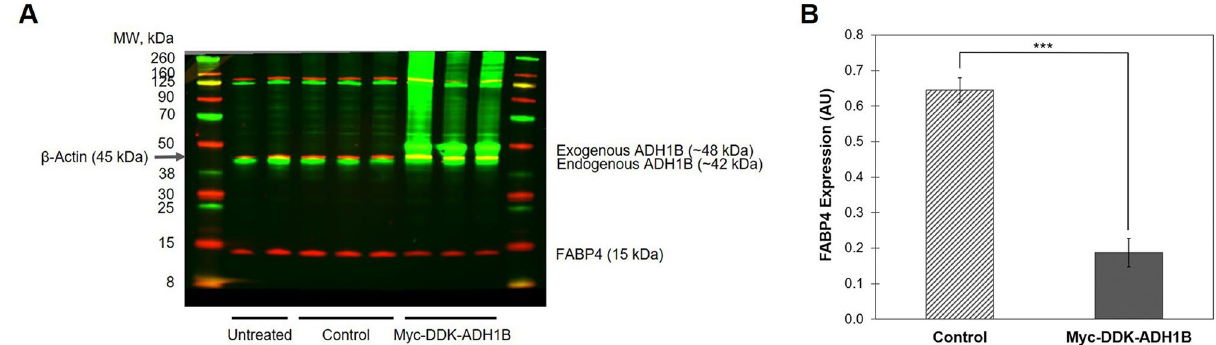
Figure 3. ADH1B regulates FABP4 expression during adipocyte differentiation. ( A ) Immunoblot analysis of cell lysates from adipocytes following differentiation and transduction with lentiviruses. Pre-adipocytes were transduced with lentivirus containing empty vector (Control) or vector encoding myc-DDK-tagged human ADH1B on Day 0 and Day 10 of differentiation in triplicate. Untreated pre-adipocytes were differentiated in duplicate and utilized as an additional control. Total protein was collected following complete differentiation, resolved by SDS-PAGE, and immunoblotted with antibodies specific for ADH1B, FABP4, and β-actin control. ( B ) Quantitative analysis of FABP4 expression in cells overexpressing ADH1B compared to empty vector control. Biological replicates were processed on the same Western blot. Fluorescence intensity was quantified and normalized to β-Actin control. Data is presented as the mean ± s.e.m. AU, Arbitrary Units; ***P =